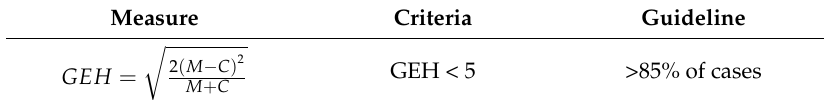
Table 1. Validation criteria (Adapted from U.K. DMRB, [36]). In GEH calculation formula, M is the hourly traffic volume from the traffic model and C is the real-world hourly traffic count. Measure Criteria Guideline (cid:114) 2 ( M − C ) 2 GEH < 5 >85% of GEH = M + C